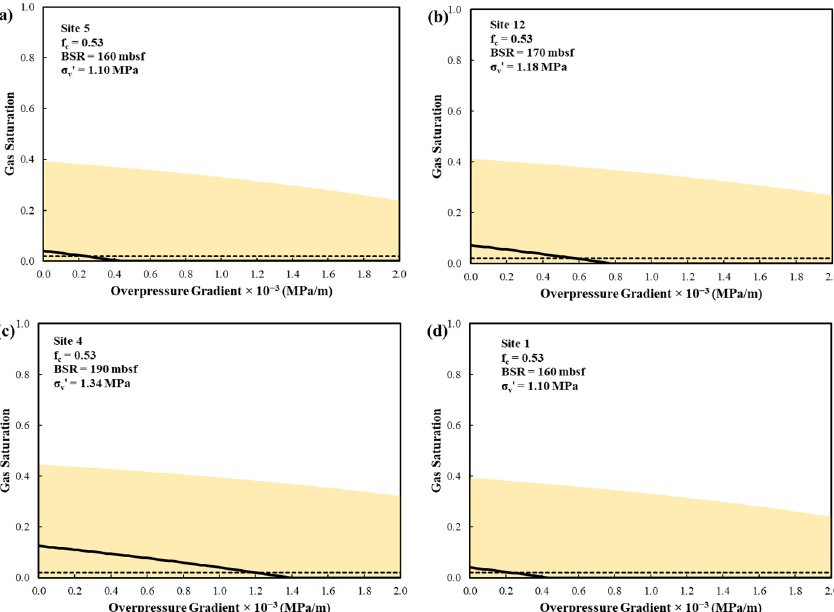
Figure 11. Minimum gas saturation required to open fractures for the 4 sites for varying overpressure gradients ( dP */ dz ). The sites are shown from west to east. Site 5 ( a ) is the westernmost, followed by Site 12 ( b ), Site 4 ( c ) and Site 1 ( d ). The black curves show the median prediction of minimum gas saturation (obtained by substituting Equation (7) into Equation (13) and solving for the saturations) required to open fractures for a given overpressure gradient and the shaded region is the uncertainty ( ± 1 SD). The black dotted line is the gas mobility threshold.